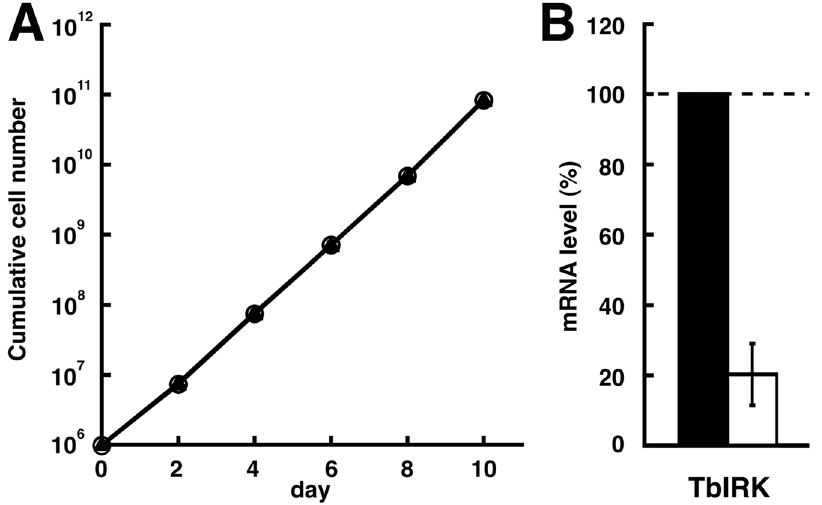
Figure 6. RNAi-mediated downregulation of TbIRK in procyclic form parasites. ( A ) Growth of non-induced (open circles) and induced (triangles) was monitored over 10 days (mean ± S.D., n = 3; error bars are smaller than the symbols). Induction of RNAi against TbIRK did not result in a growth phenotype. Changes in target mRNA levels were confirmed by qPCR ( B ). The black bar represents the mRNA level of non-induced cells and the white bar represents the mRNA level of TbIRK in induced cells. TbIRK mRNA was downregulated by 80 ± 9% (mean ± S.D., n =